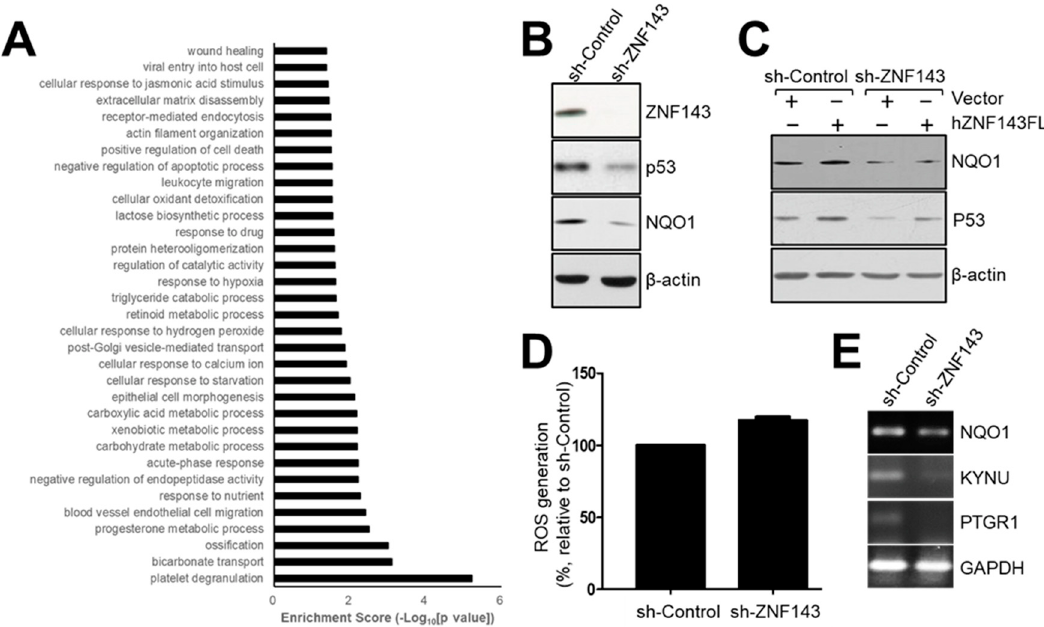
Figure 5. NQO1 is reduced in ZNF143-silenced breast cancer cells, and is important for p53 stability. ( A ) Growing cells were harvested and subjected to liquid chromatography–mass spectrometry to profile altered proteins by ZNF143 knockdown. Approximately 5000 proteins were profiled, and 177